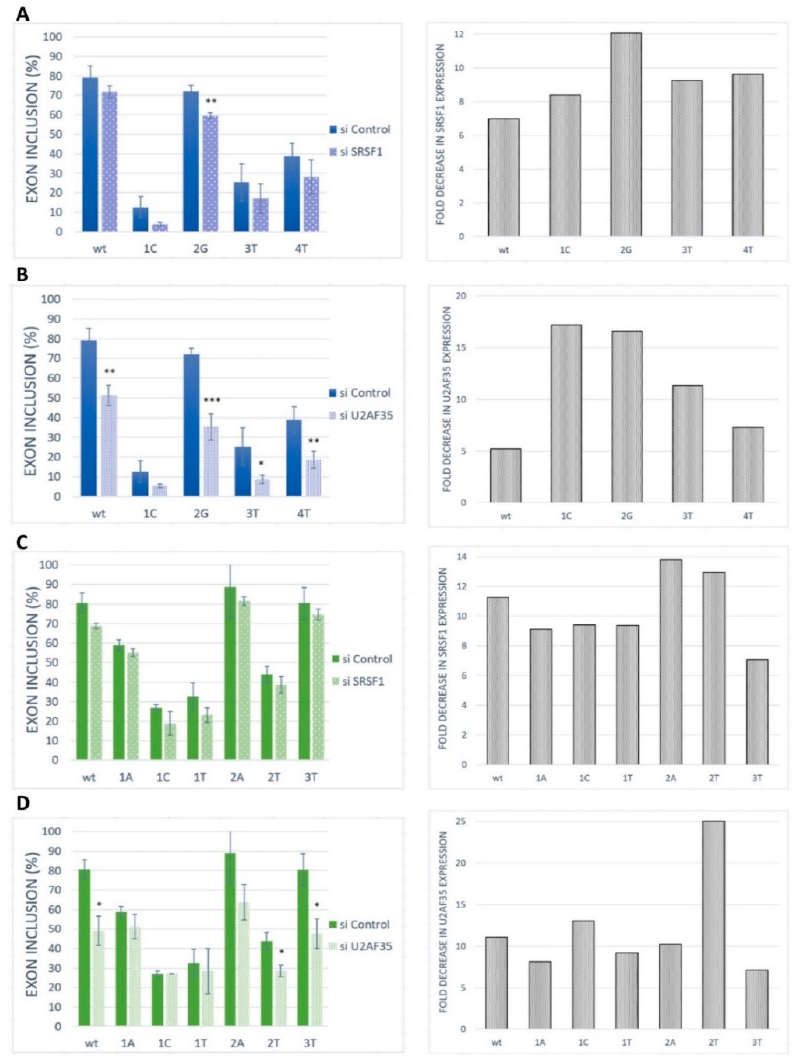
Figure 5. E ff ect of SRSF1 and U2AF35 knockdown. HeLa cells were transfected with either a control (si control) or specific siRNA (si SRSF1 or si U2AF35). Graphs demonstrate the proportions of exon inclusion upon SRSF1 ( A , C ) or U2AF35 ( B , D ) knockdown in BRCA2 exon 12 ( A , B ) or VARS2 exon 17 ( C , D ). Exon inclusion from different minigenes is compared to control transfection (si control). Error bars represent SDs obtained from three independent experiments. Statistically significant differences are shown (* p < 0.05, ** p < 0.01, and *** p < 0.001). On the right, SRSF1 or U2AF35 expression levels are shown as fold-change compared to control transfections (si control). SRSF1 or U2AF35 expression level upon SRSF1 or U2AF35 knockdown (grey bars) relative to SRSF1 or U2AF35 level upon control knockdown is shown.